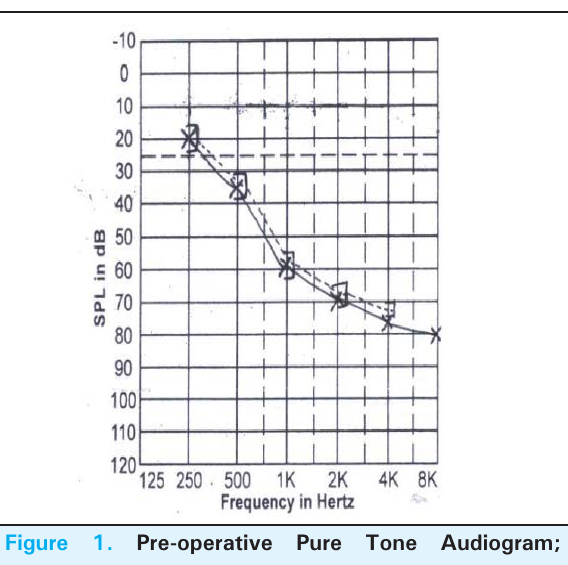
Figure 3. Contrast enhanced coronal T1 weighted MRI scan displaying left cerebellopontine angle vestibular schwanomma